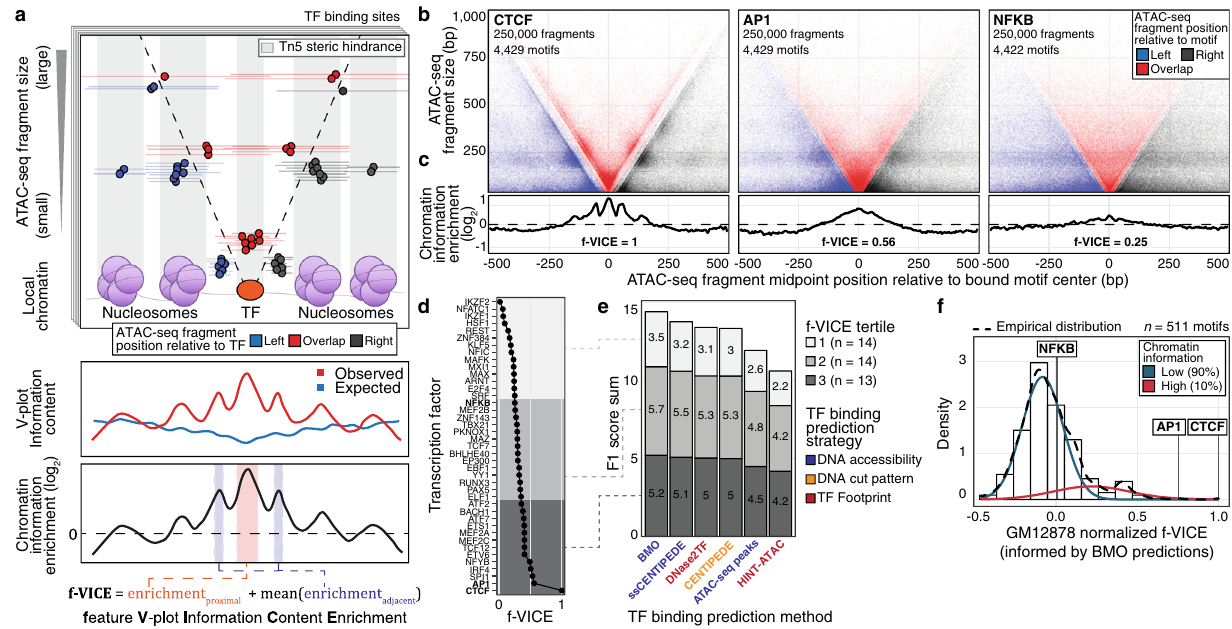
Fig. 1 Information content of TF-chromatin interactions. a Upper: TF binding impacts the chromatin architecture and the observed ATAC-seq fragment distribution around TF binding sites. Middle and bottom: calculation of CIE and f-VICE. b , c V-plots and CIEs of CTCF, AP-1, and NFKB (GM12878 ATAC- seq data generated in this study). V-plots were downsampled to highlight differences in chromatin architecture (but not for f-VICE calculation). d f-VICEs calculated for TFs with GM12878 ChIP-seq data. e F1 score sum of TF binding prediction algorithms. f Normalized GM12878 BMO-informed f-VICE